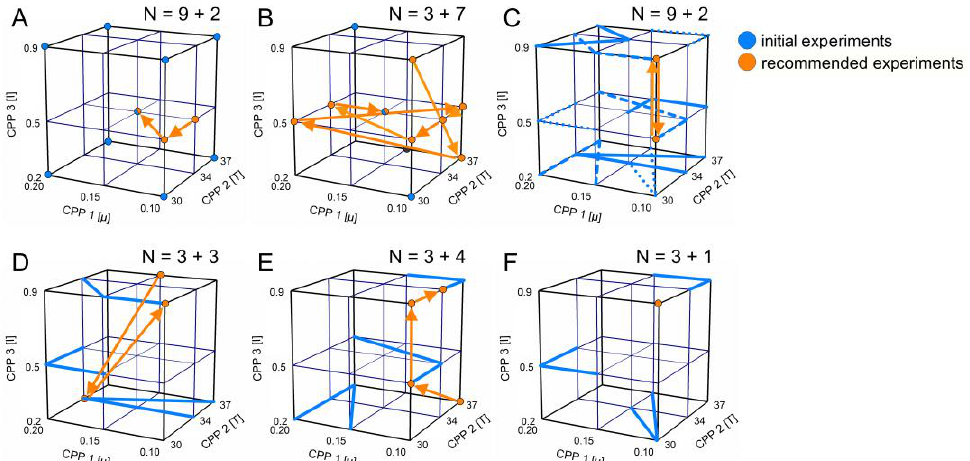
Figure A1. Step-by-step progressions of the recommended experiments by the model-based DoE, using varying initial data sets. The initial experiments (blue circles and lines) and the respective recommendations for the next experiment (orange dots), along with the temporal order (orange arrows) are given. The fractional factorial DoE with nine ( A ) and three ( B ) initial static cultivations, the complete iDoE ( C ), and the three fractional factorial iDoEs ( D – F ) are presented. In conclusion, while every approach using static cultivations as a basis for model-based DoE could identify the optimum CPP combination in the design space, all the iDoE approaches failed to do so. However, it was already shown that the concept of iDoE is advantageous for reducing the experimental effort for process characterization but, in this particular case, it was not possible for model-based DoE to accurately identify the static process conditions optimizing a certain process output. The recommended CPP combinations by the model-based DoE with the initial iDoE cultivations were becoming trapped at high values or local maxima and were highly biased towards the highest induction level, slowest growth rate, and lower cultivation temperatures.